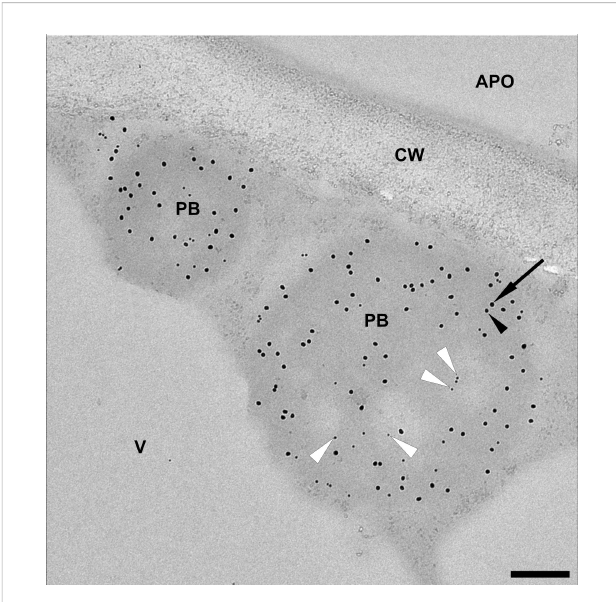
FIGURE 6 Representative electron microscopy image indicating the incorporation of the model antigen into multi-component PBs. Immunogold labelling of an in fi ltrated leaf sample shows protein bodies (PB) composed of Zera-EGFP (18 nm gold particles, arrow), 16- kDa- g -zein-BFP (10 nm gold particles, black arrowhead) and 15-kDa- b -zein- Opt3a12- fl ag (6 nm gold particles, white arrowheads). Note that the 6 nm particles, corresponding to the localization of the antigen, are preferentially found in the lighter areas of the PB. Protein body (pb), apoplast (apo), cell wall (cw), vacuole (v). Scale bar 0.25